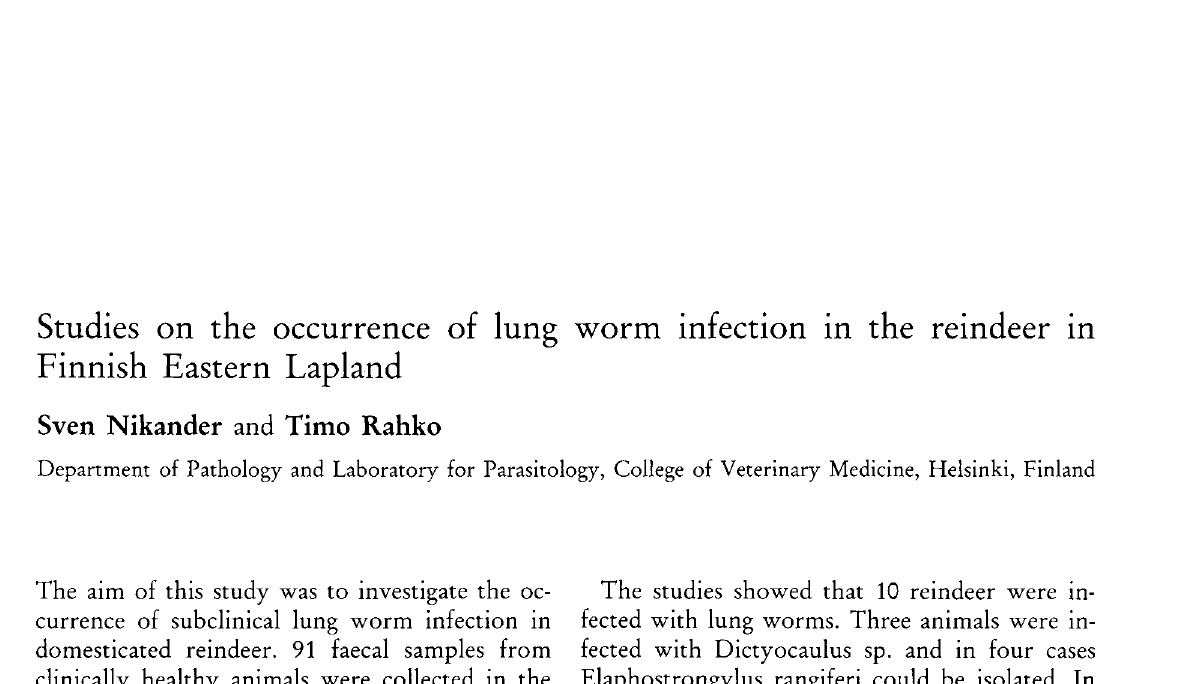
Table 2. The occurrence of lung worm larvae in fae cal samples of 12 clinically healthy reindeer not successfully treated with